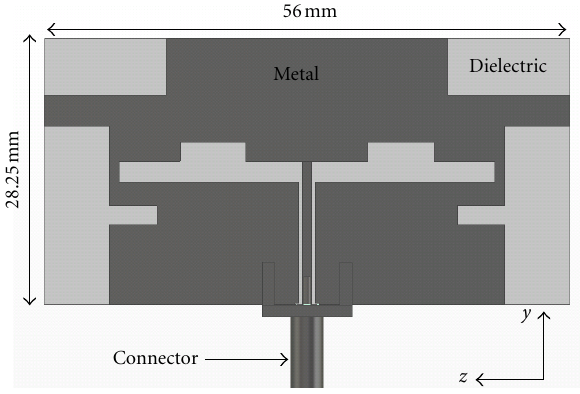
Figure 7: Geometry of the reference MSA antenna without metallic